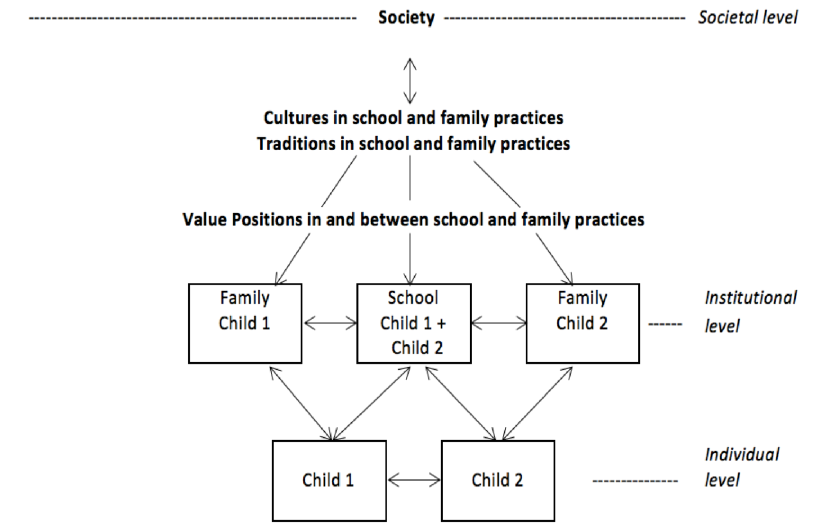
Figure 1 Children’s Participation in Different Microsystems (Family and School) Encountering and Integrating Different Perspectives (Societal, Institutional, and